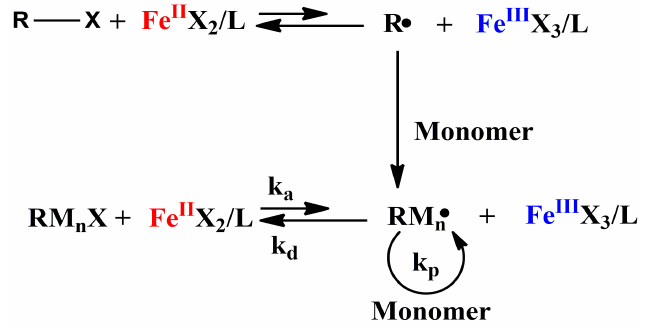
Figure 1. Mechanism of normal ATRP catalyzed by iron(II) complex.